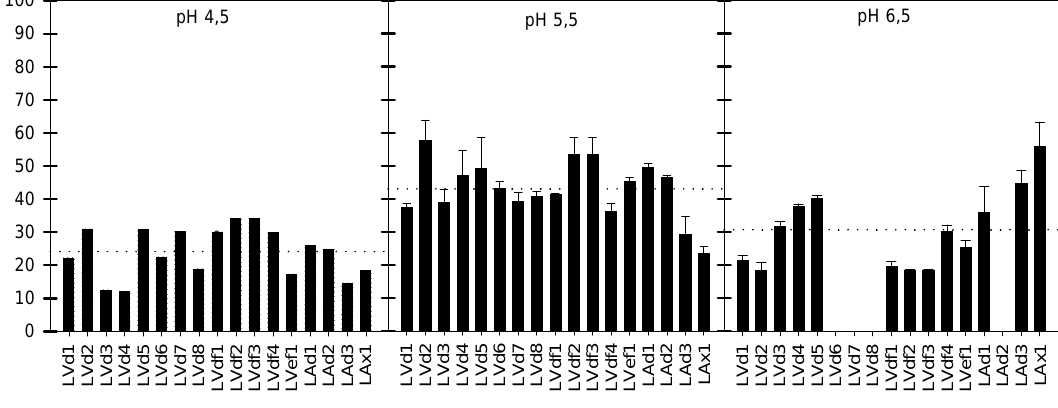
Figura 5. Fração percentual de Cd dessorvido [Cd por amostras de diferentes classes de Latossolos brasileiros previamente submetidos à adsorção com Cd(NO ) 0,20 mmol L -1 , em três valores de pH da solução de equilíbrio [Ca(NO 3 2 relação solo:solução 1:100; pH 4,5; 5,5 e 6,5]. (LVd = Latossolo Vermelho distrófico típico; LVdf = Latossolo Vermelho distroférrico típico, Lvef = Latossolos Vermelho eutroférrico típico; Lad = Latossolo Amarelo distrófico típico; Lax = Latossolo Amarelo coeso). A linha pontilhada indica a média. As barras de erro representam o desvio-padrão (n = 3).